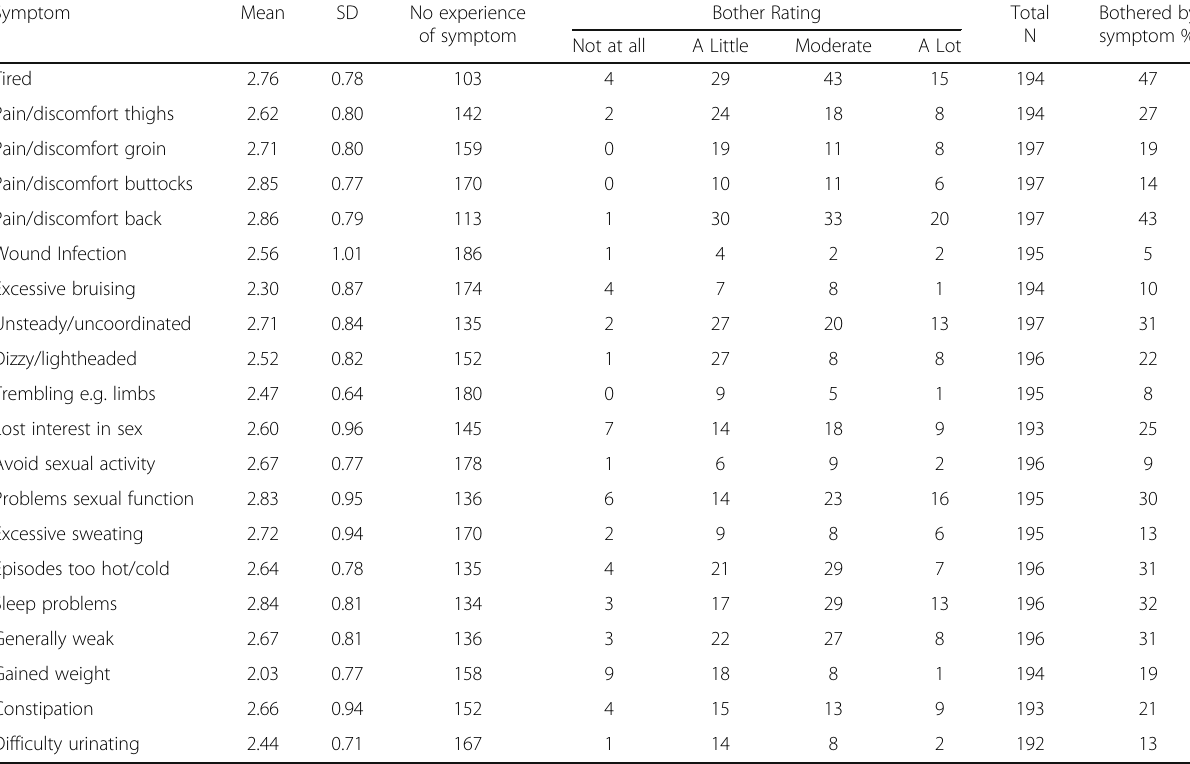
Table 6 AneurysmSRQ frequency scores and bother ratings for all stand-alone items ordered by item number Symptom Mean SD No experience of symptom